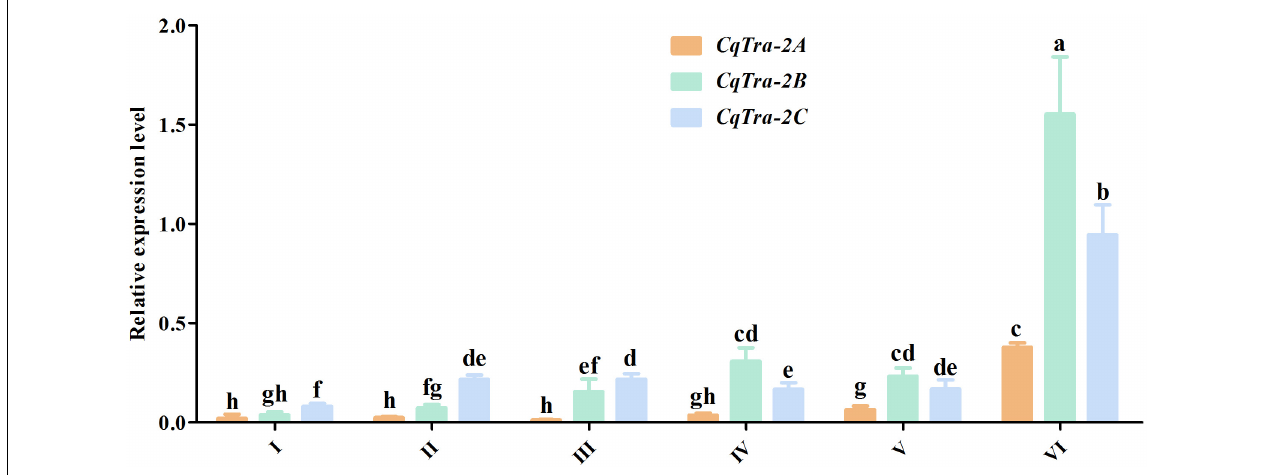
FIGURE 4 | Expression pattern of CqTra-2 genes in different embryonic development stages of C. quadricarinatus . The 18S-rRNA gene is used as control. (I) Fertilized eggs, (II) cleavage and blastula, (III) gastrula, (IV) nauplius, (V) eye pigments forming, and VI) prehatching. Data are shown as means ± SD. Bars with different letters were considered significant at p <